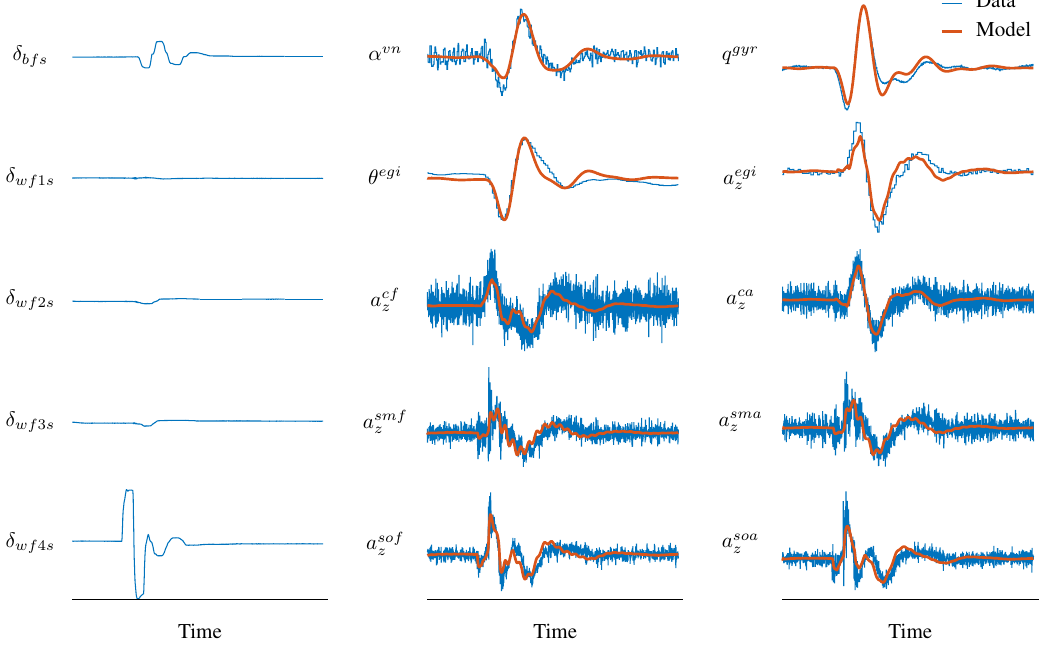
Figure 7. Model validation data (Flight 19, FTA 6232, 64% fuel, 82% flutter speed).